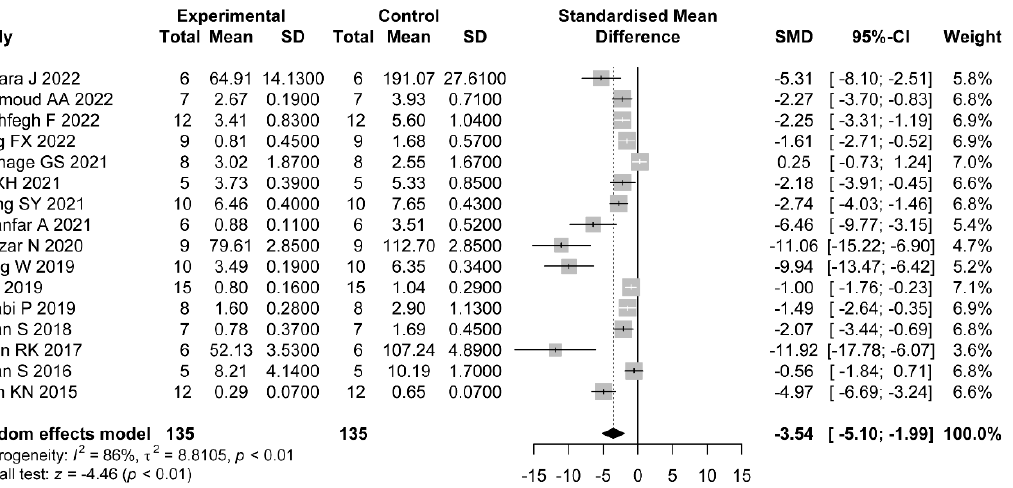
Figure 8. Forest plot of flavonoids of